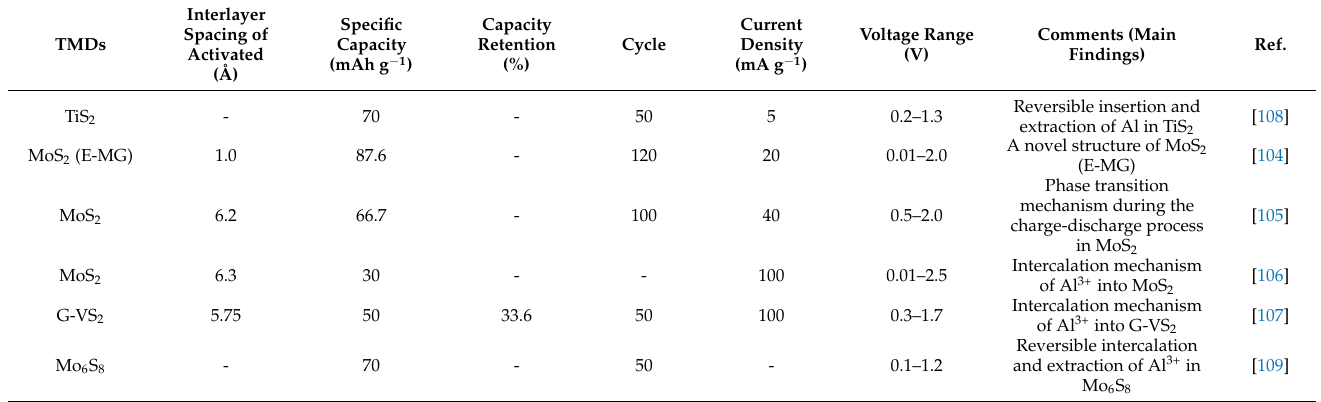
Figure 10. Cyclic performance of ( a ) TiS 2 and ( b ) Cu 0.31 Ti 2 S 4 at room temperature and 50 °C at 5 mA g − 1 . Reprinted with permission from Geng et al. [108] Copyright 2017, American Chemical Society. ( c ) Schematic structure of Al insertion sites in Mo 6 S 8 , ( d ) cyclic performance of Mo 6 S 8 . Reprinted with permission from Geng et al. [109] Copyright 2015, American Chemical Society. Table 4. Electrochemical performance of TMD cathodes for aluminum-ion batteries (AIBs).